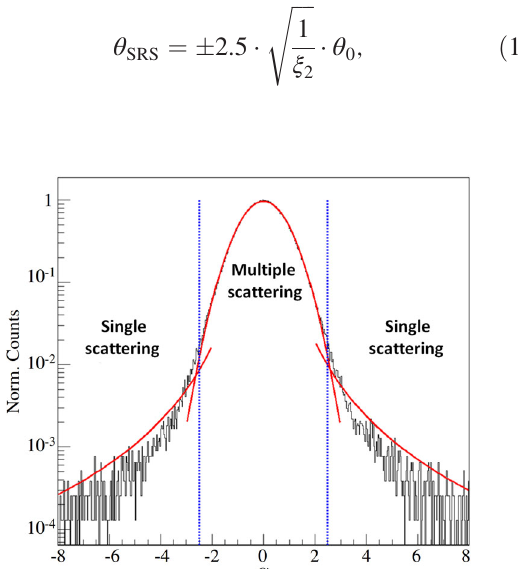
FIG. 4. Angular distribution of a scattered proton beam from graphite in function of the projected angle α simulated in OPAL . The red curves are the fit from the multiple and single scattering distributions [Eq. (8) and (9)]. The dashed-blue lines set the transition between multiple and single